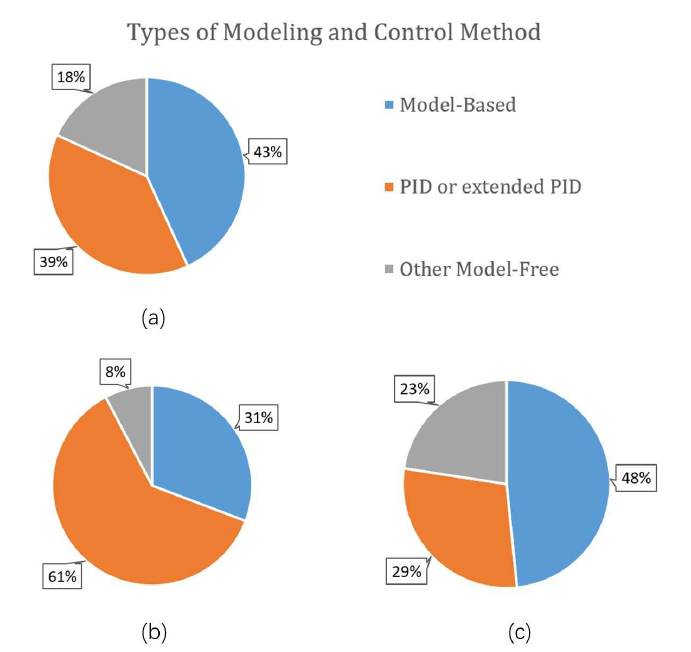
Figure 7. Types of control strategies and their percentage in this review. ( a ) Overall proportion of SRNCRs; ( b ) Proportion of SRNCRs based on tendon-driven; ( c ) Proportion of SRNCRs based on soft intelligent